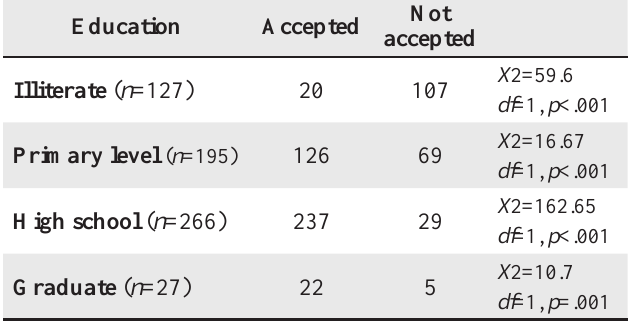
Table 4 : Education status and acceptance of contraception in